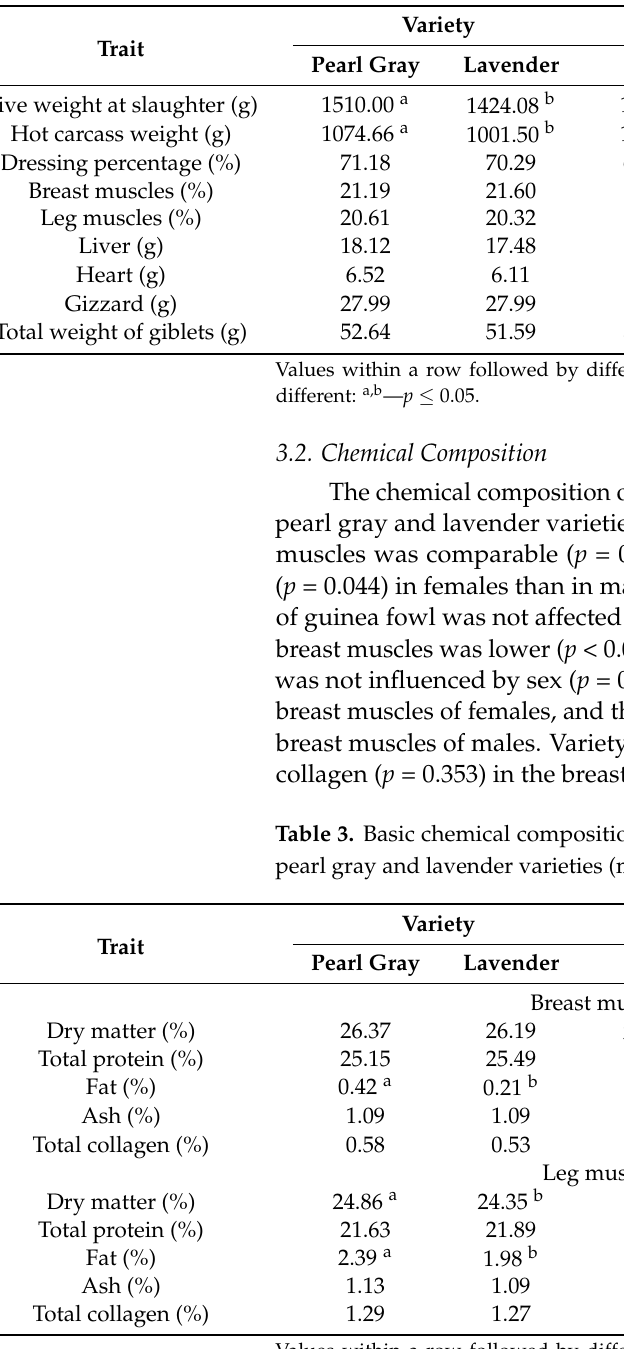
different: a,b — p ≤ 0.05. The leg muscles of pearl gray guinea fowl, compared with those of lavender birds, had a higher content of dry matter ( p ≤ 0.029) and fat ( p ≤ 0.017) (Table 3). No